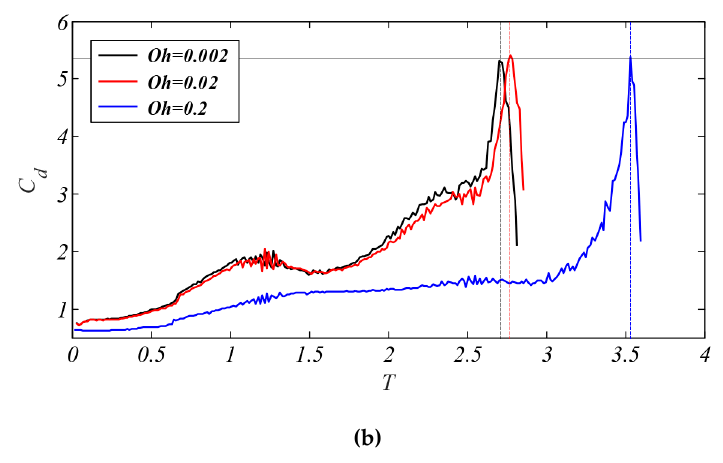
Figure 13. The temporal evolution of the droplet drag coefficient. ( a ) The drag coefficient under different We number ( Oh = 0.002); ( b ) the drag coefficient under different Oh number ( We = 18.5).